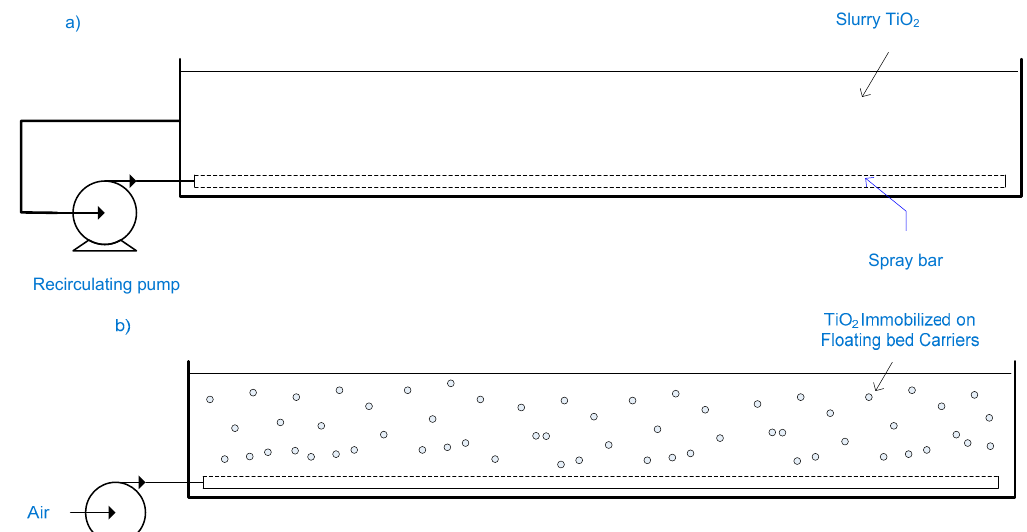
Figure 3. Schematic drawing of: a ) shallow pond employing slurry TiO 2 ; and b ) fluidized bed shallow pond reactor.